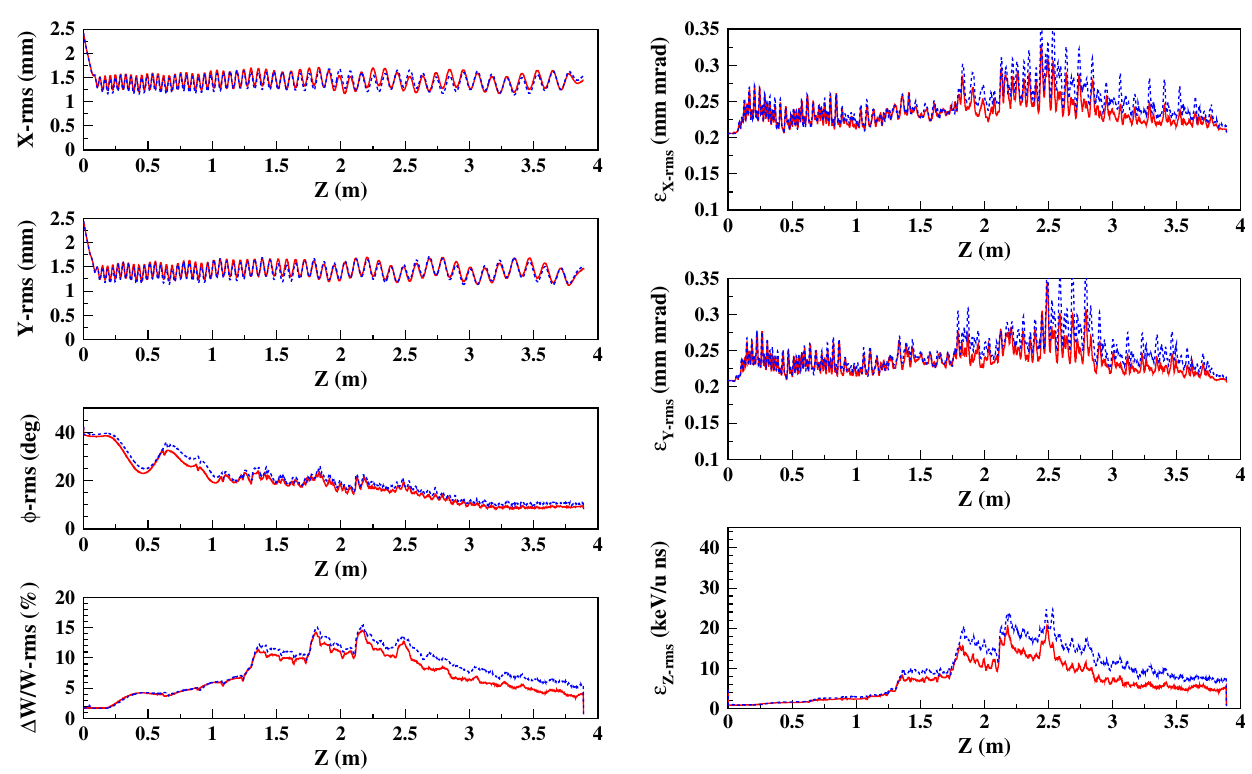
FIG. 9. Comparison between the cell-by-cell (solid red) and the full-cavity 3D models (dashed blue) for the final trapezoidal design. On the left are rms beam envelopes and on the right rms beam emittances along the RFQ. The curves include all particles within the aperture (accelerated or not). The peaks and valleys on the longitudinal plots, corresponding to oscillations of nonaccelerated particles, are present in the sinusoidal section but they disappear in the trapezoidal section of the RFQ.